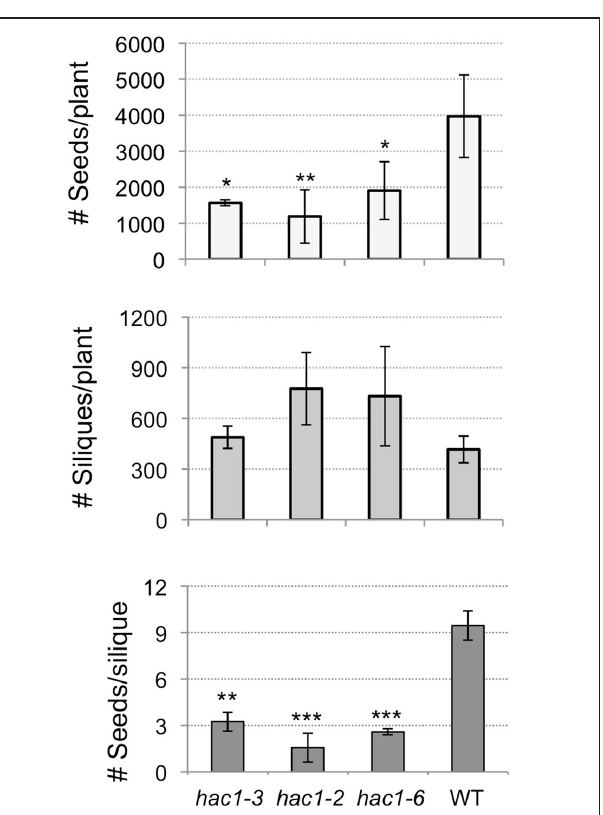
FIGURE 4 | The hac1 mutants are moderately resistant to the inhibitory effects of paclobutrazol on seed germination. Mutant and wild-type Col-0 (WT) seeds were surface sterilized, imbibed in the dark at 4 ◦ C for 3 days and then sown on Petri plates with Arabidopsis minimal media and 0 or 34 μ M paclobutrazol. The Petri plates were incubated under continuous light at 22 ◦ C and scored for seed germination at regular intervals. The spy-3 mutant (Jacobsen and Olszewski, 1993) was included as a positive control. Error bars indicate standard deviations. N = 2.